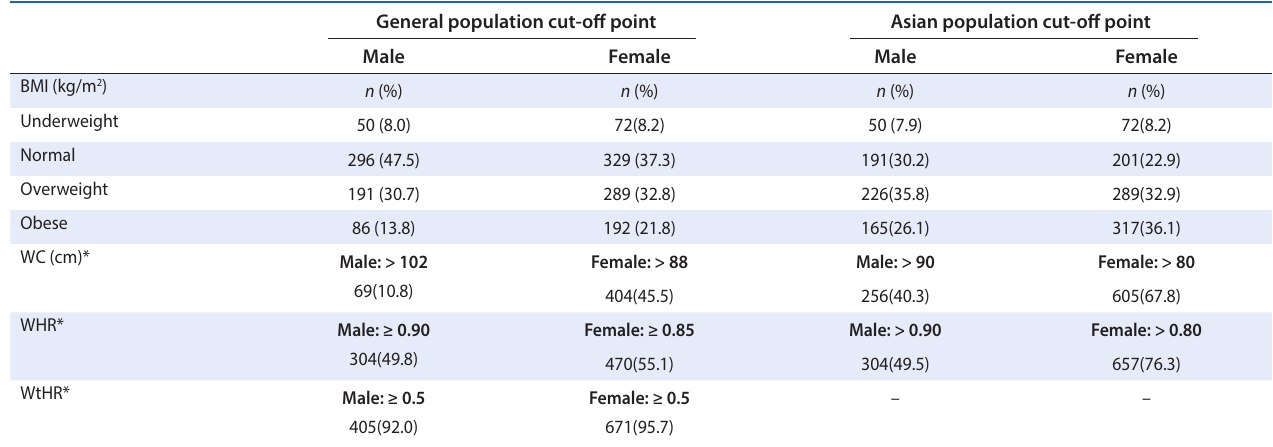
Table 1: Sex differences of obesity indices by different cut-off points General population cut-off